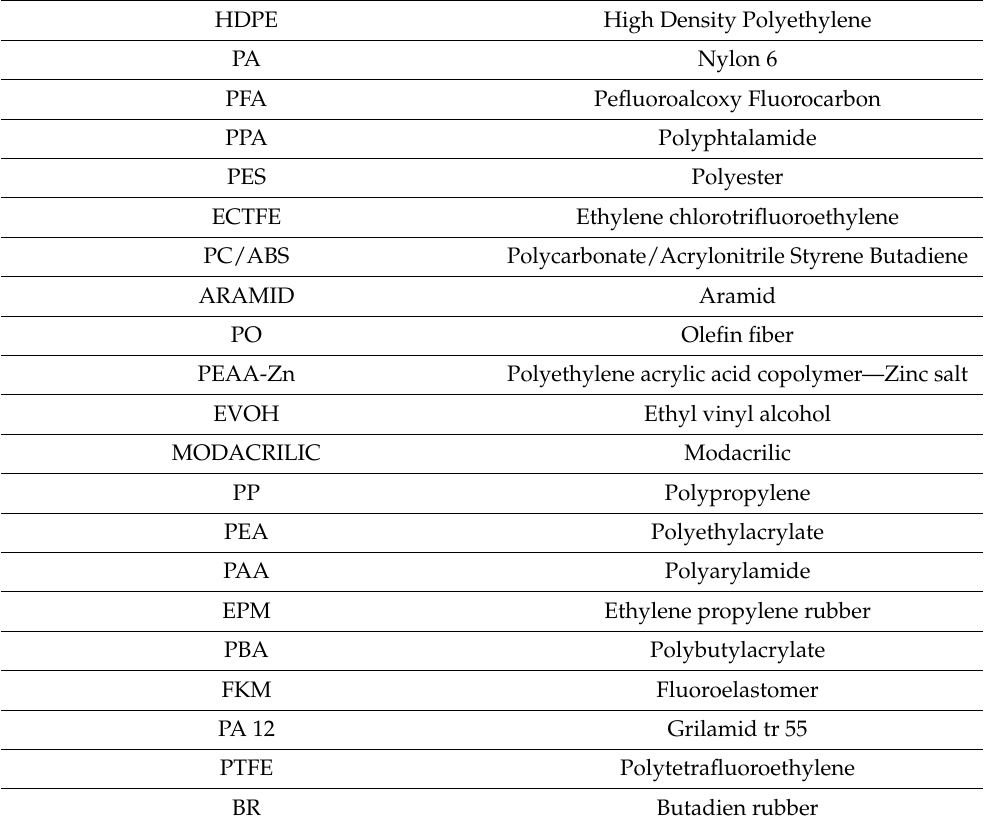
Table 1. List of the polymers identified and quantified in the specimens of S. equinuum and S. ornatum , collected in the Treja and Mignone rivers. HDPE